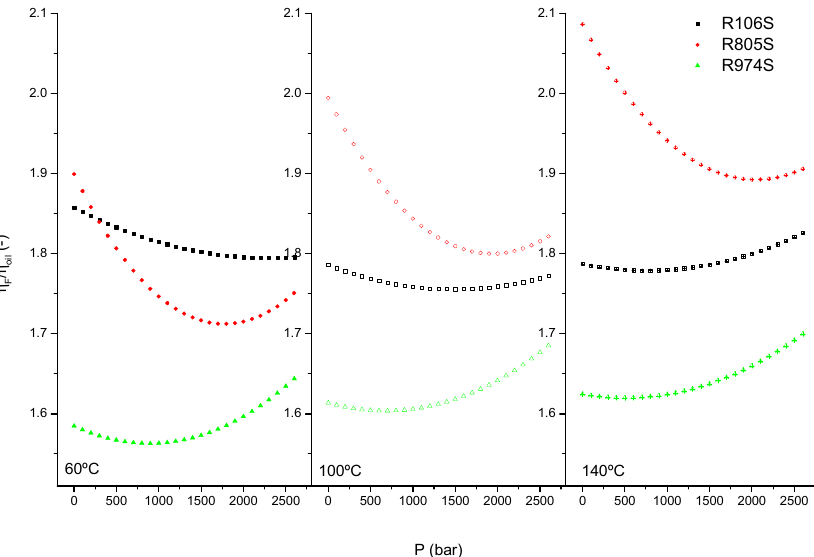
Figure 8. Evolution of the relative viscosity versus pressure for selected temperatures, 60, 100 and 120 °C.